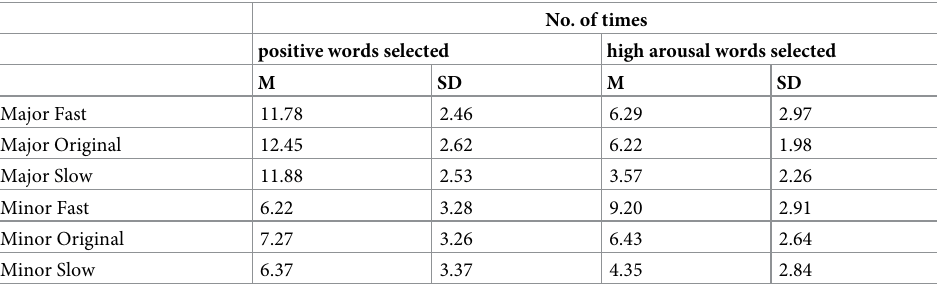
Table 3. Means and Standard deviations of words chosen in various music